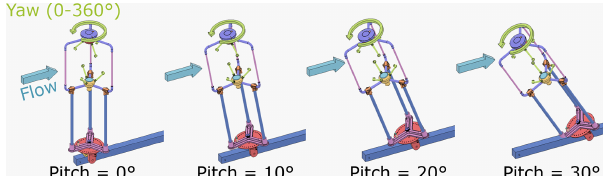
Figure 6. Wind tunnel tests of the 3-D wind sensing capabilities. Rotation around the yaw axis (green arrow) for four different pitch angles (from left to right: 0, 10, 20 and 30 ◦ ). Wind is coming from the left (blue arrow). A GNSS receiver is mounted on top of the anemometer.